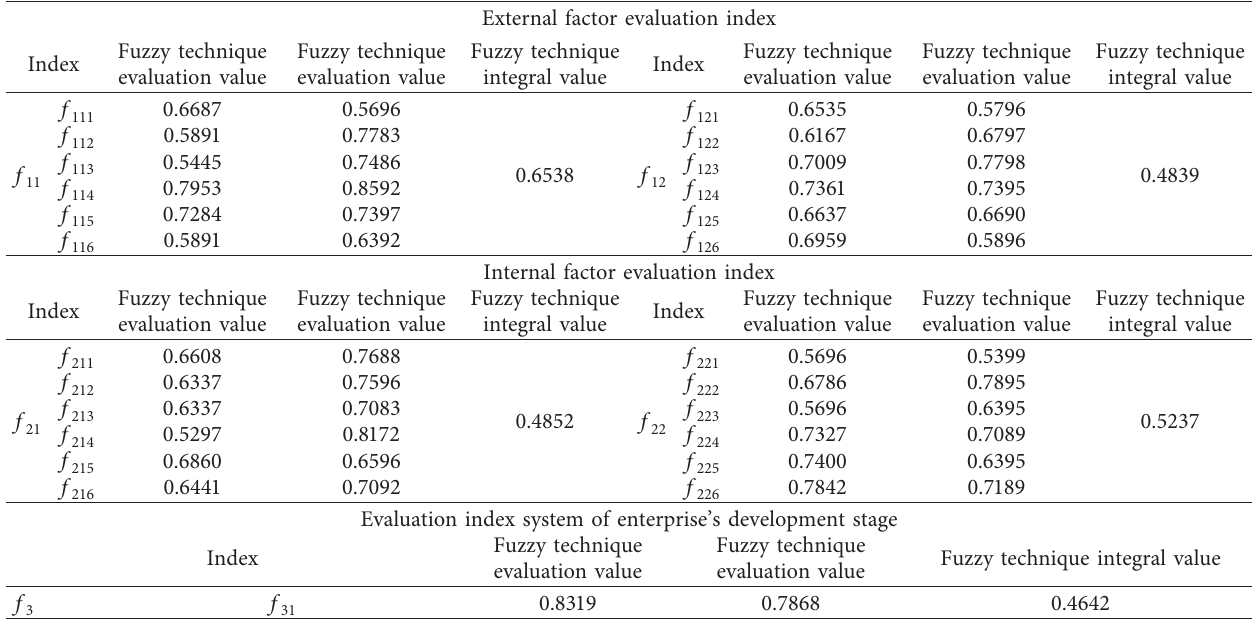
Table 4: ARR advance intelligent manufacturing-vision strategic path four-level index and fuzzy technique integral value.